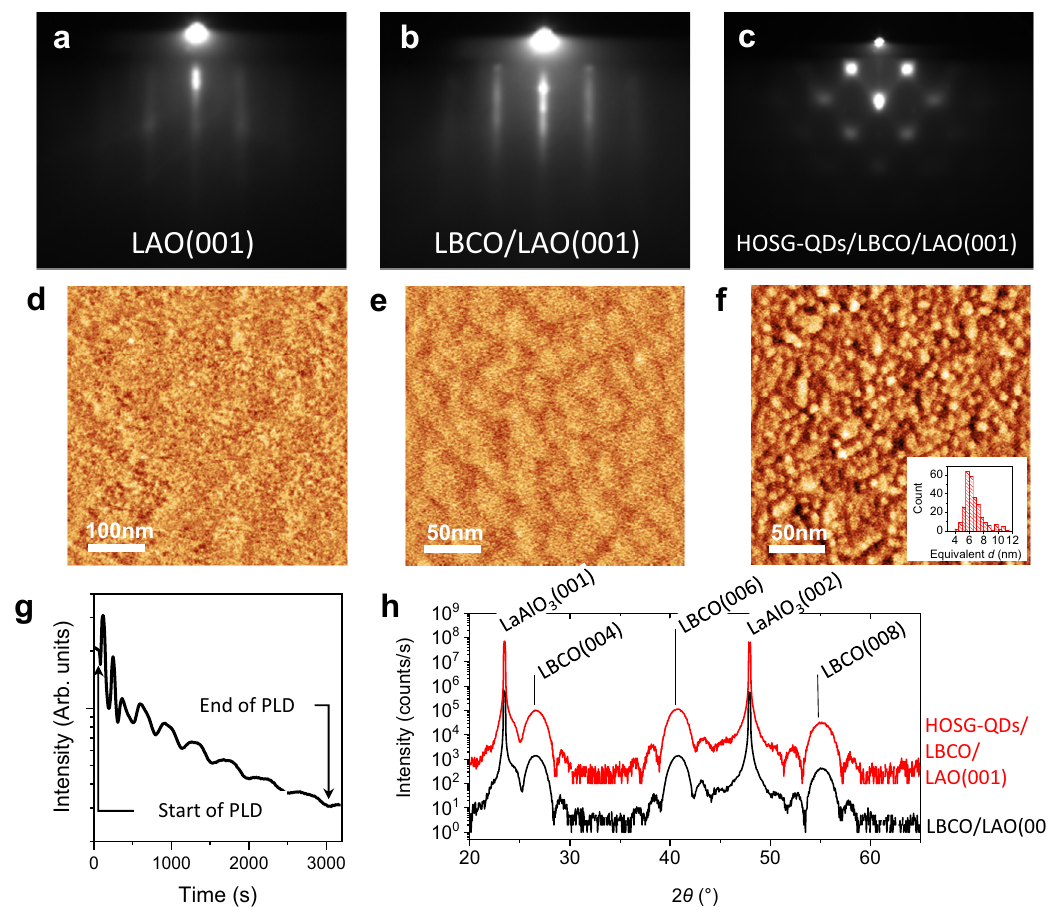
Fig. 2 RHEED, XRD, and AFM images of HOSG-QDs/LBCO/LAO(001). a – c RHEED patterns of cleaned LAO(001), LBCO/LAO(001) and HOSG-QDs/ LBCO/LAO(001). AFM corresponding surface morphologies are shown in d – f . d clean LAO(001) surface appears smooth with a surface roughness R q of 0.14 nm. e the LBCO fi lm surface appears smooth with R q of 0.53 nm. g the HOSG-QDs have an average size of about 6.57 ± 1.28 nm (size-distribution shown in inset f ). g RHEED intensity oscillations were observed during the PLD of LBCO. h θ − 2 θ scan of LBCO/LAO(001) with and without HOSG-QDs. Both samples show the presence of LBCO (I4/mmm Supplementary Table 2) the ratio of HDP to UHB is ~0.60 ± 0.05